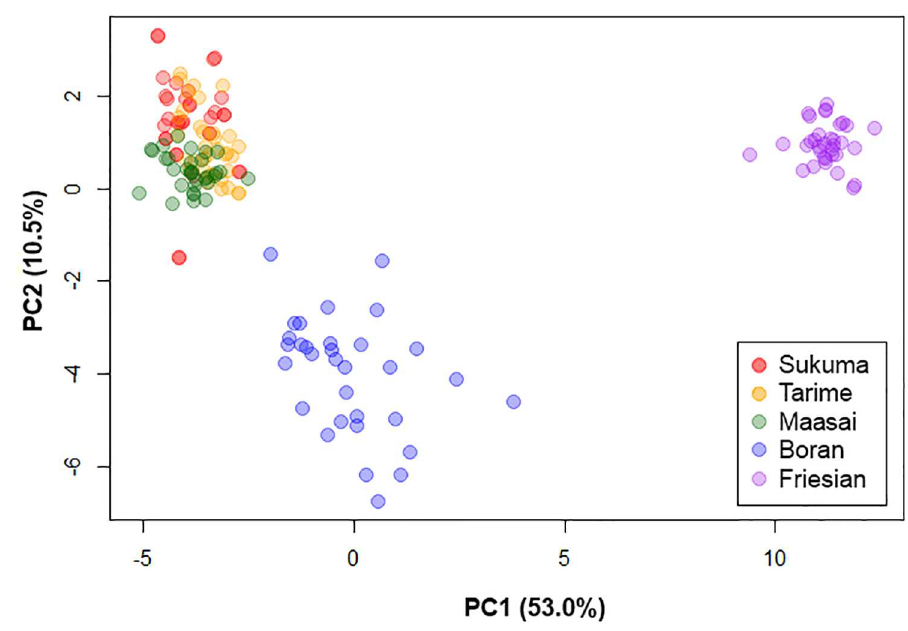
Fig 2. Principal components analysis between individuals of Tanzanian cattle. Sukuma (red), Tarime (yellow),Maasai (green), Boran (blue) and Friesian (purple)are indicatedin different